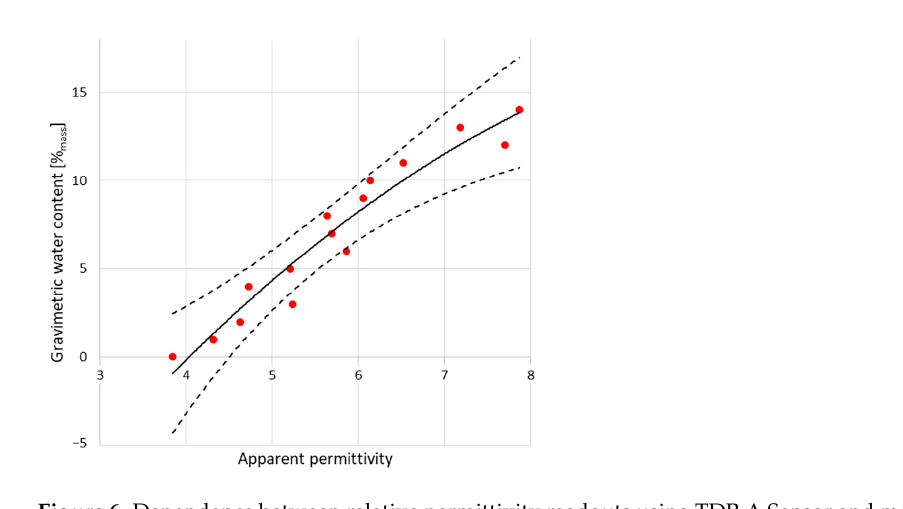
Figure 6. Dependence between relative permittivity readouts using TDR A Sensor and mass moisture evaluated gravimetrically.